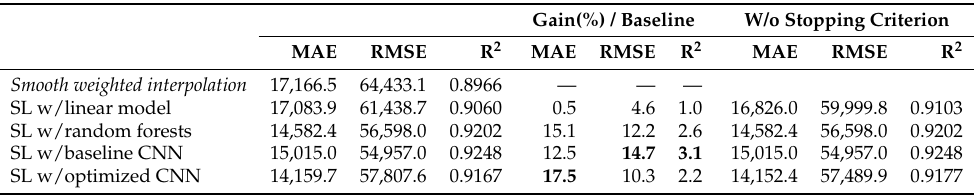
Table 9. Results obtained with the self-training approach using different regression algorithms for the overall amount of national